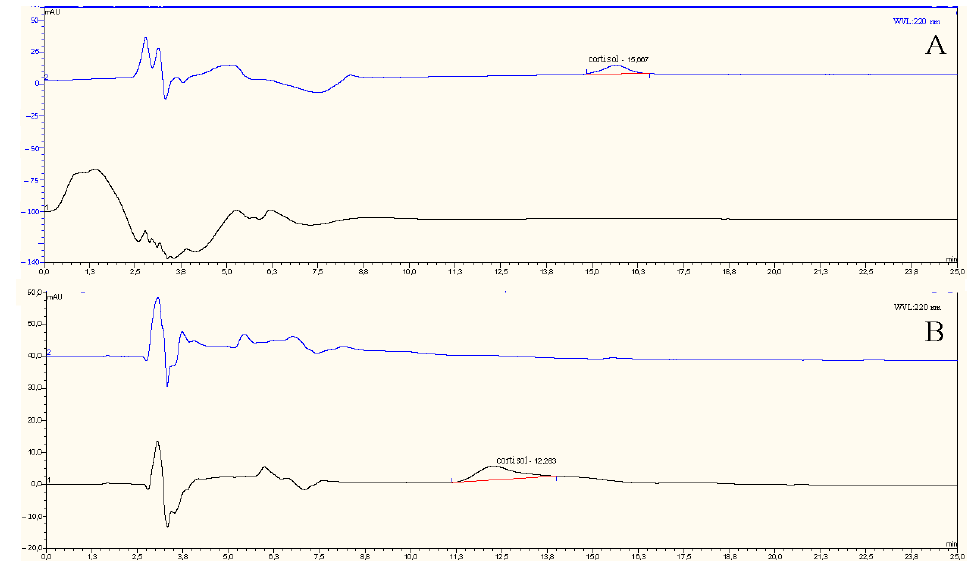
Figure 8. HPLC chromatograms of cortisol-spiked and unspiked artificial urine ( A ) and artificial plasma ( B ) samples.